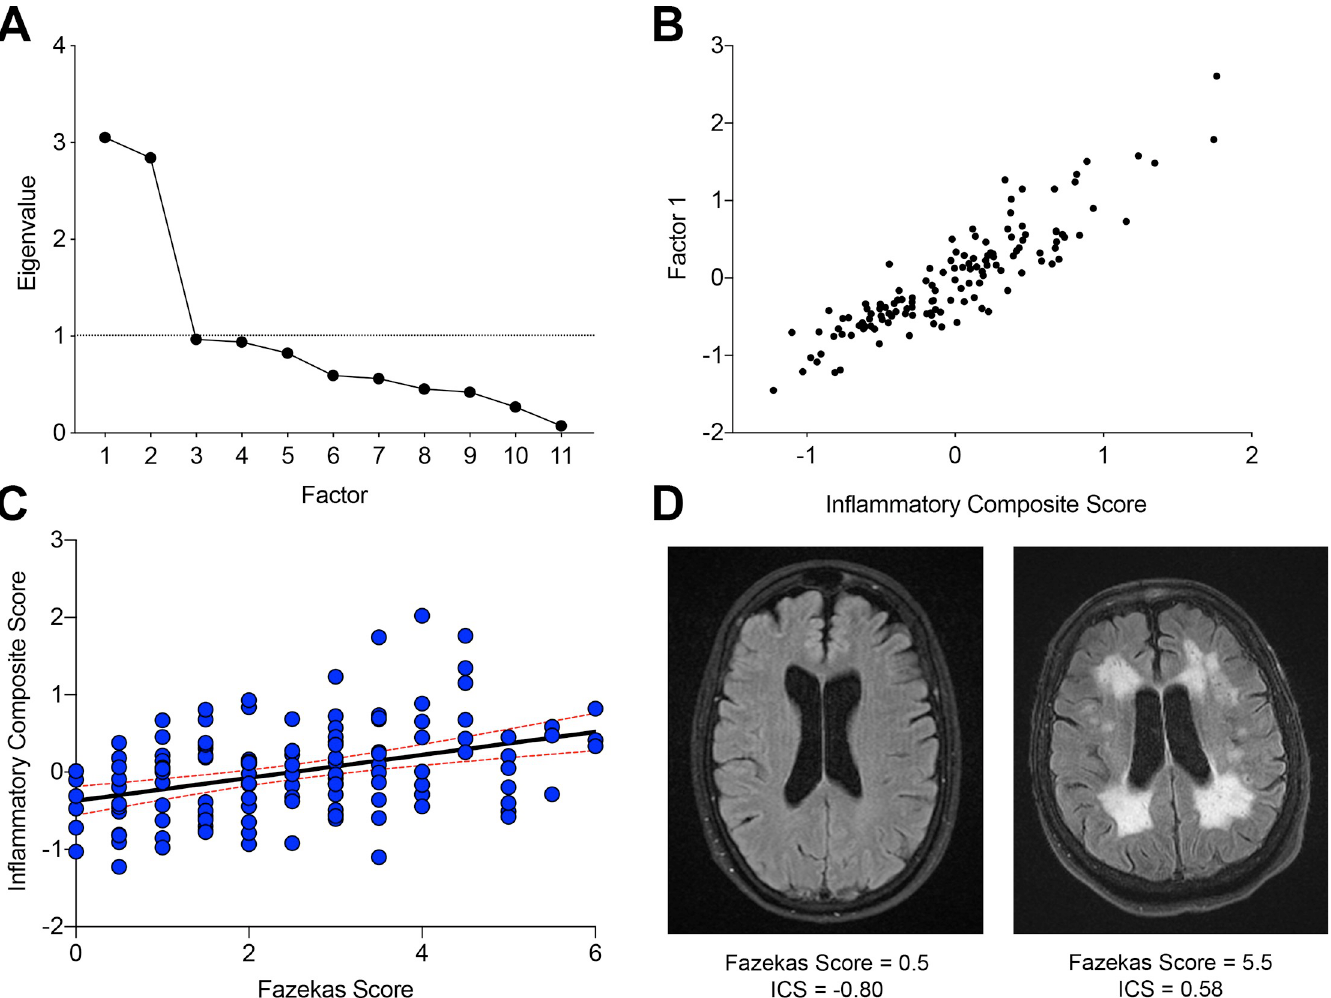
Fig 6. ICS is associated with white matter injury in those at risk for stroke. Scree plot of principal components analysis of data from ASPIRE cohort serum biomarker panel with two main factors (Factor 1 and Factor 2) driving variance (A). Scatter plot of Factor 1 values versus ICS in this cohort demonstrating a significant correlation ( r = 0.94) (B). Scatter plot and regression line of modified Fazekas score and ICS for individual subjects (C). Red dashed lines indicate 95% confidence intervals. Representative T2/FLAIR MR images of ASPIRE subjects with low (left) or high (right) ICS scores (D).